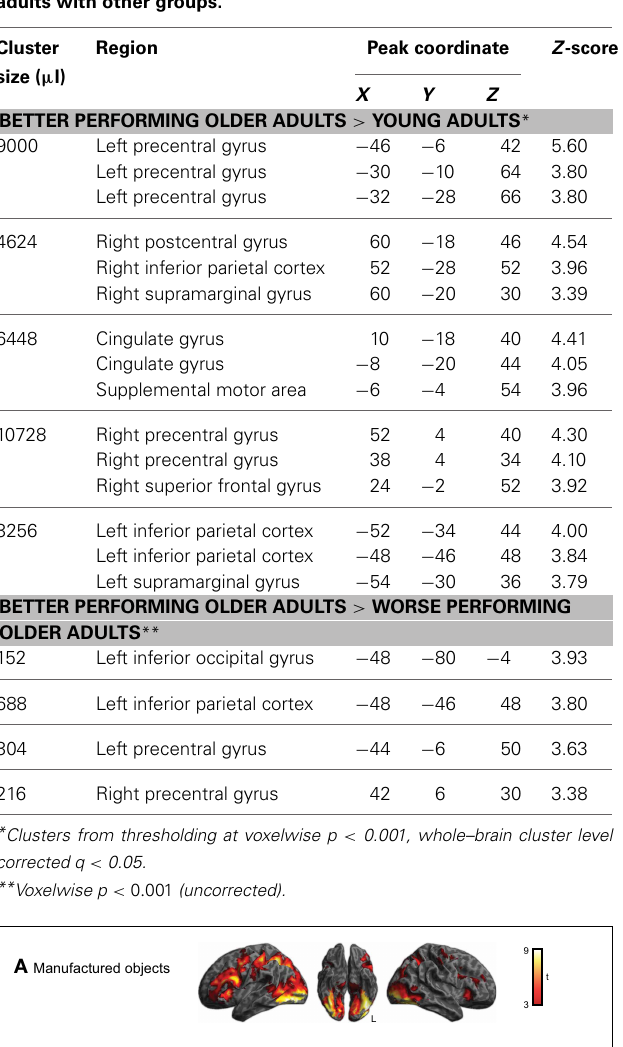
Table 2 | Maxima for fMRI activity comparing better performing older adults with other groups.